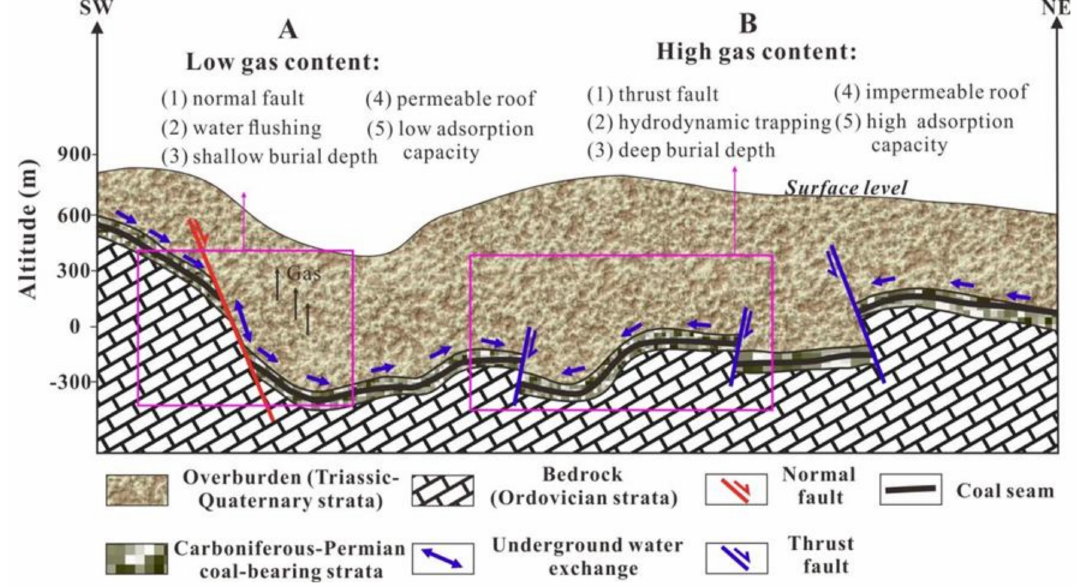
Figure 12. Geological scenarios controlling CBM content of the No.5 coal seam in the Weibei Field. ( A ) shows low gas content model; ( B ) shows high gas content